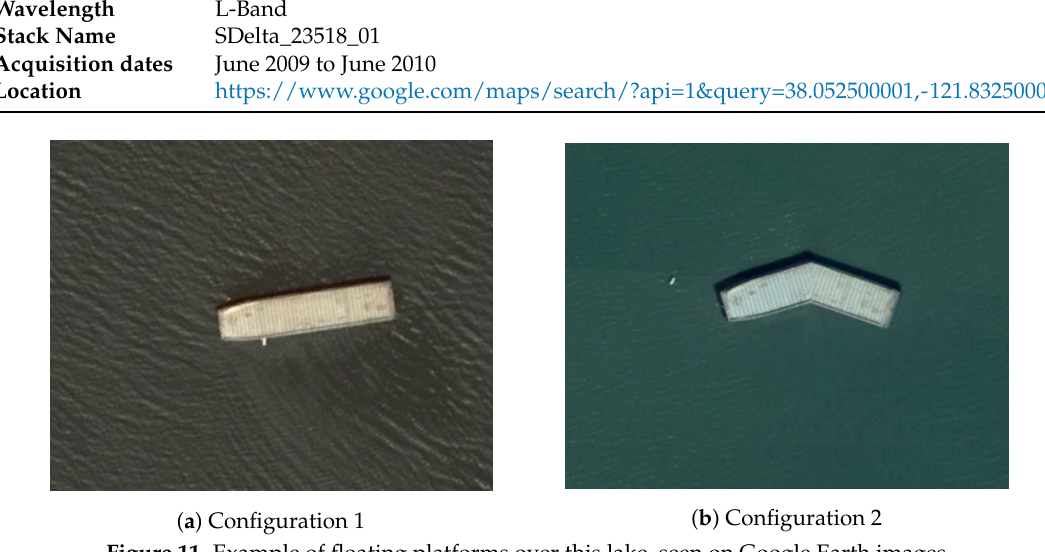
Figure 11. Example of floating platforms over this lake, seen on Google Earth images.